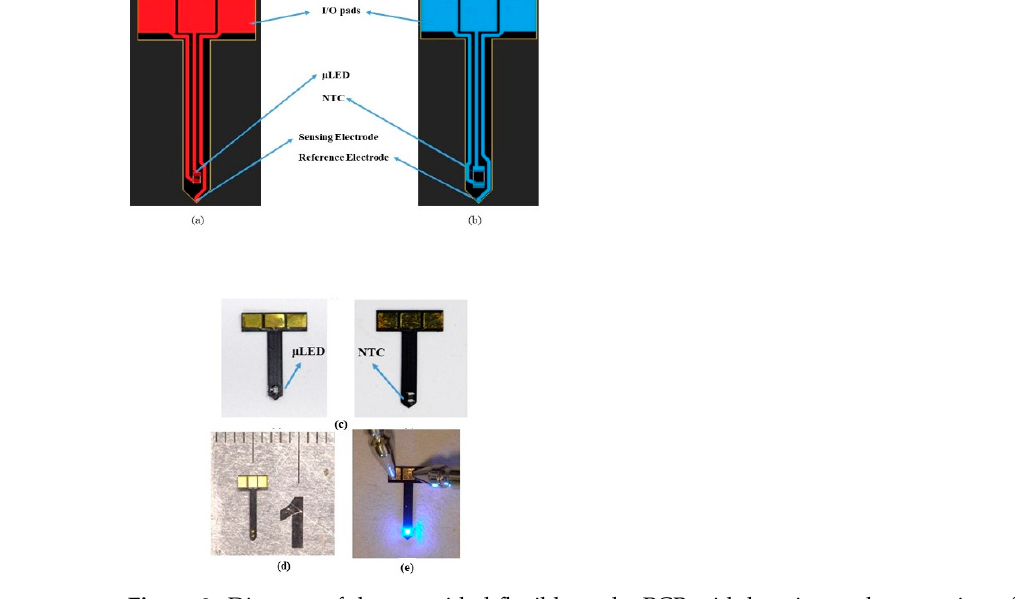
Figure 2. Diagram of the two-sided flexible probe PCB with location and connection of different components. Fabricated probe: ( a ) front view, ( b ) back view, ( c ) µLED attached on the front and temperature sensor attached on the back, ( d ) size comparison, and ( e ) µLED glowing.